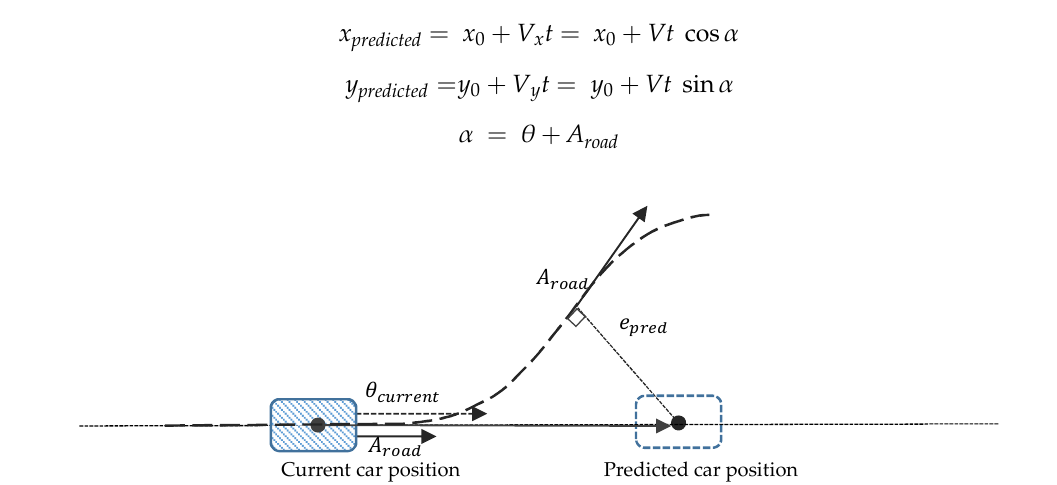
Figure 7. Predicting the lateral deviation of the car e pred . Figure 7 . Predicting the lateral deviation of the car e pred .